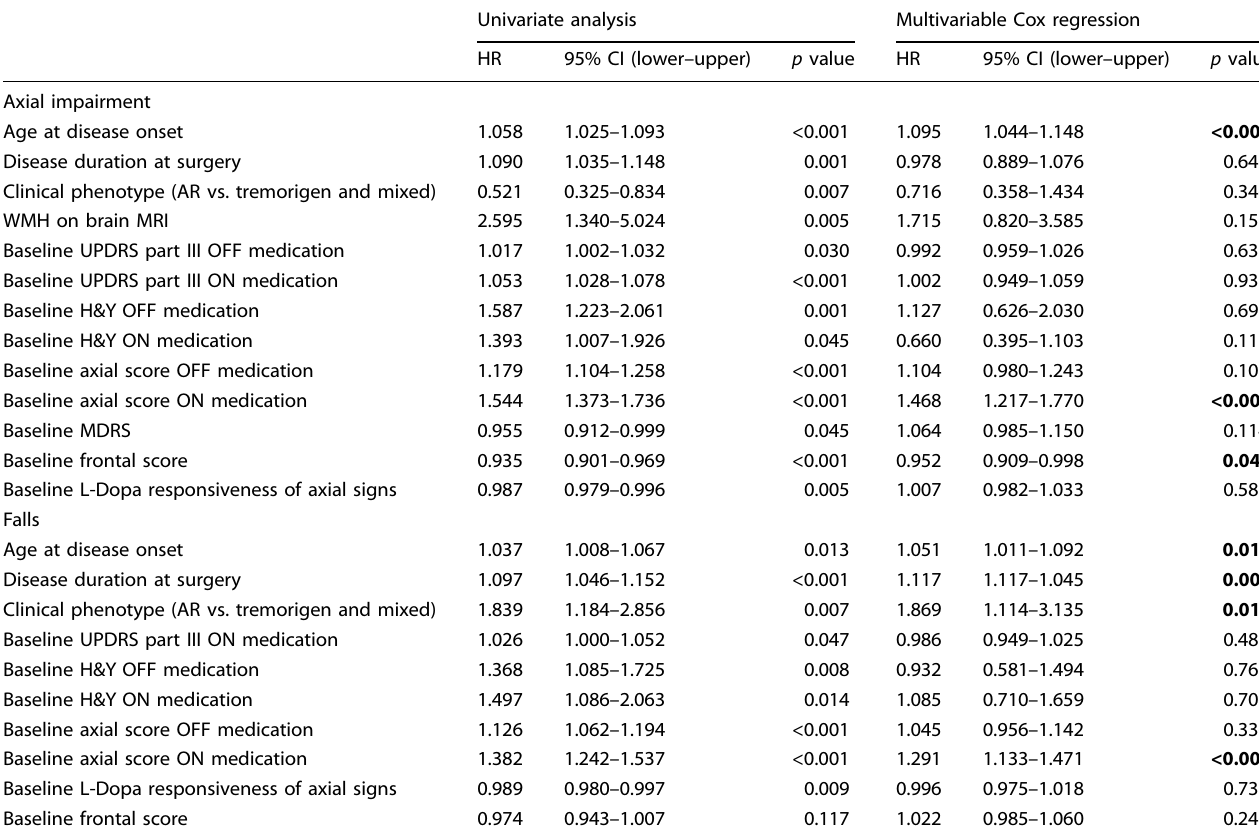
Table 2. Univariate analysis for variable selection ( p < 0.20) and multivariable Cox regression analysis for risk